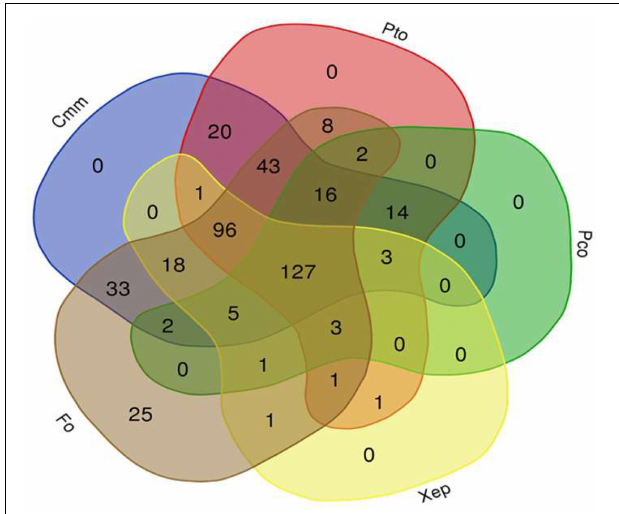
FIGURE 3 | Venn diagram showing the antagonist activity of a collection of 424 bacterial isolates obtained from tomato root environment against the tomato phytopathogenic bacteria Clavibacter michiganensis subsp. michiganensis ( Cmm ), Pseudomonas corrugata ( Pco ), P. syringae pv. tomato ( Pto ), and Xanthomonas euvesicatoria pv. perforans ( Xep ), and the fungus Fusarium oxysporum f. sp. lycopersici ( Fol